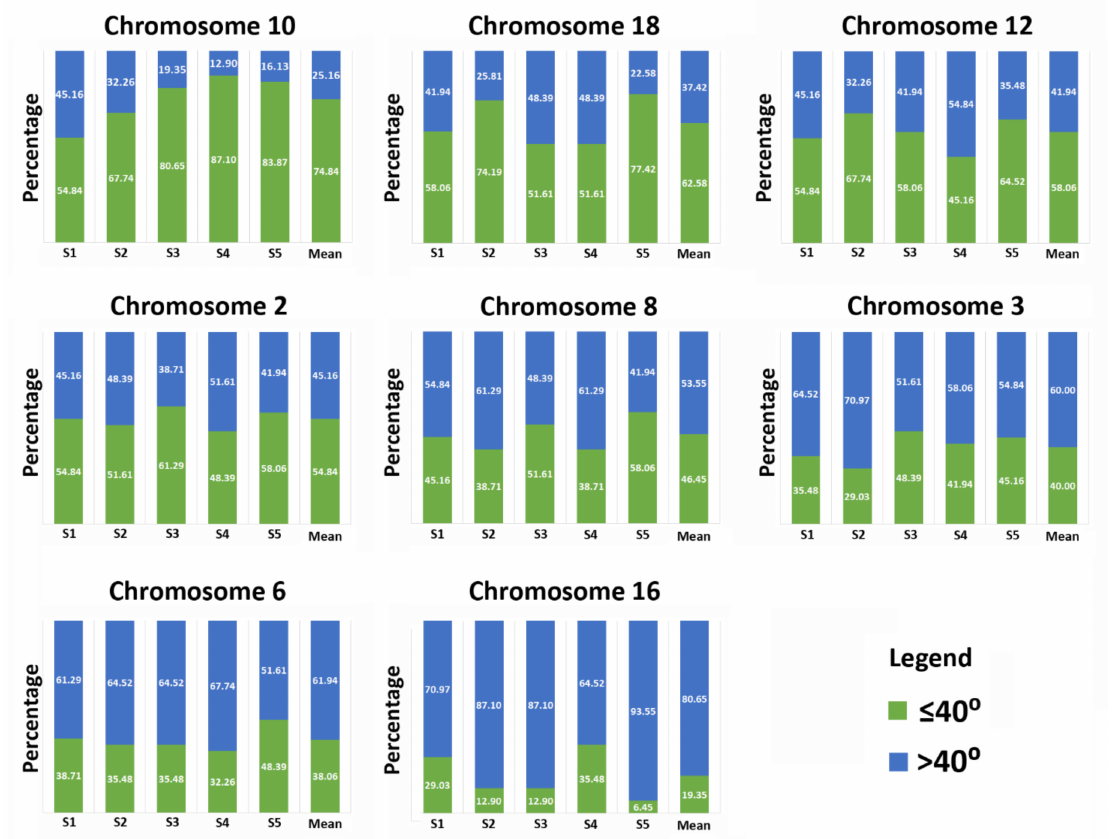
Figure 4. Chromosomes reproducibly have a tendency to form narrower or wider hairpin-loop chromosome configurations in five normozoospermic males for eight investigated chromosomes. The percentage of chromosomes forming narrow ( ≤ 40 ◦ ) or wide ( > 40 ◦ ) hairpin-loop configurations for each investigated chromosome is shown for each normozoospermic subject (S1–S5). The mean data for the five subjects is displayed on the far right for each chromosome. Data per subject, per chromosome is based on a minimum of 30 cells; whereas the mean data presented is based on a minimum of 150 cells from the five subjects. Chromosomes are ordered from the top left to the bottom right based on the percentage of narrow ( ≤ 40 ◦ ) hairpin-loop configurations for the mean data, with chromosome 6 and 16 preferentially forming the narrowest and widest hairpin-loops,